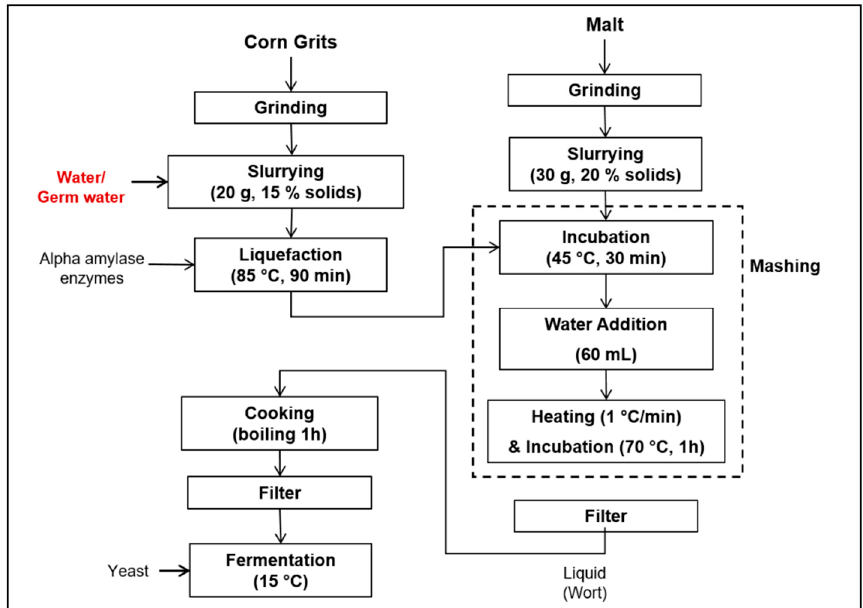
Figure 1. Schematic of steps followed for fermentation of corn grits and malt.